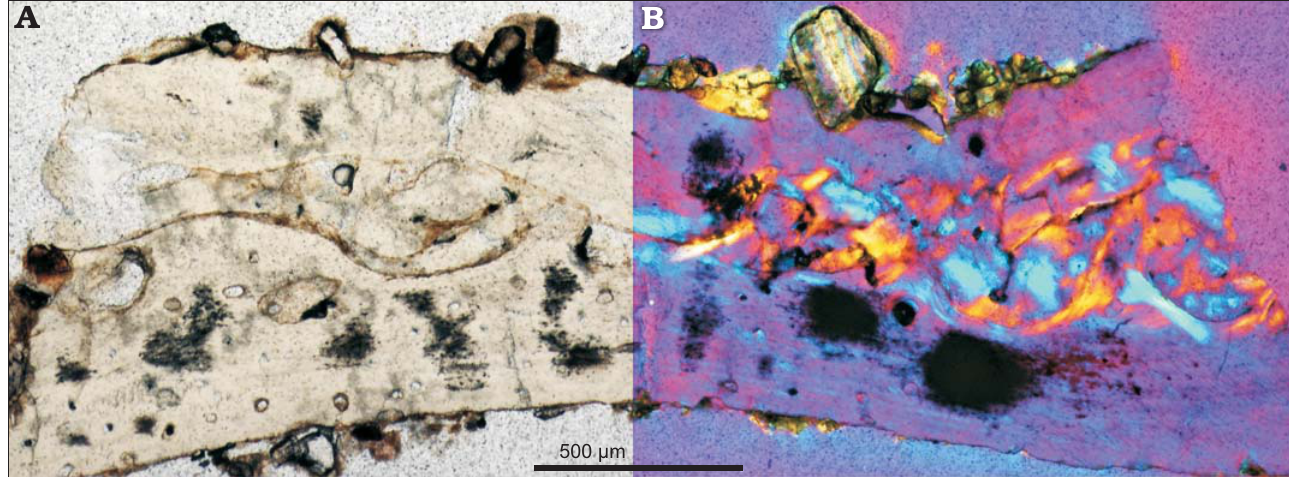
Fig. 6. Cross-section of the rib of Protoceratops andrewsi Granger and Gregory, 1923, Bayn Dzak, Mongolia, Late Cretaceous (ZPAL MgD-II/3); note the external cortex made of primary bone and extensively remodeled core formed by coarse cancellous bone tissue; in normal ( A ) and polarized ( B )